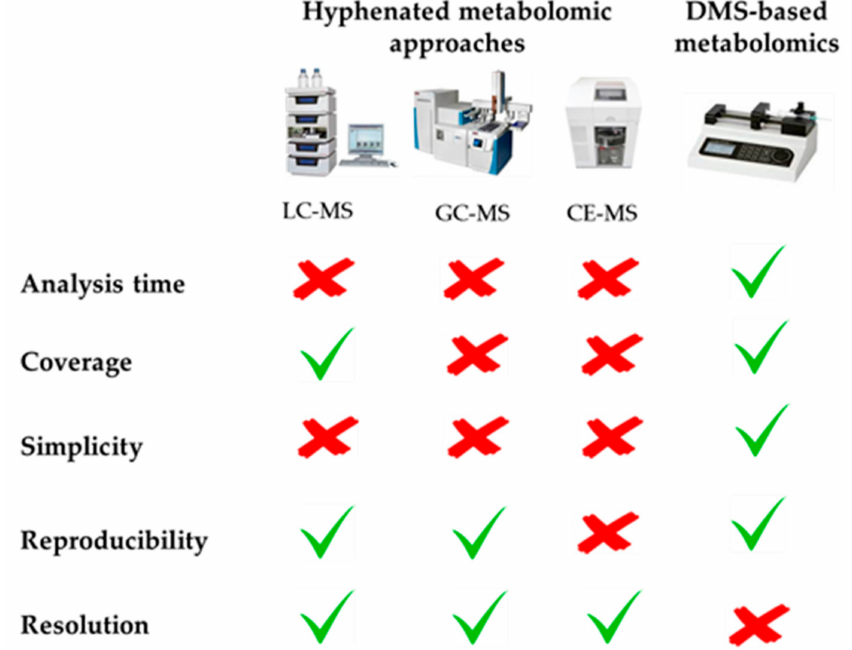
Figure 1. Advantages and drawbacks of DMS-based metabolomics compared with conventional hyphenated